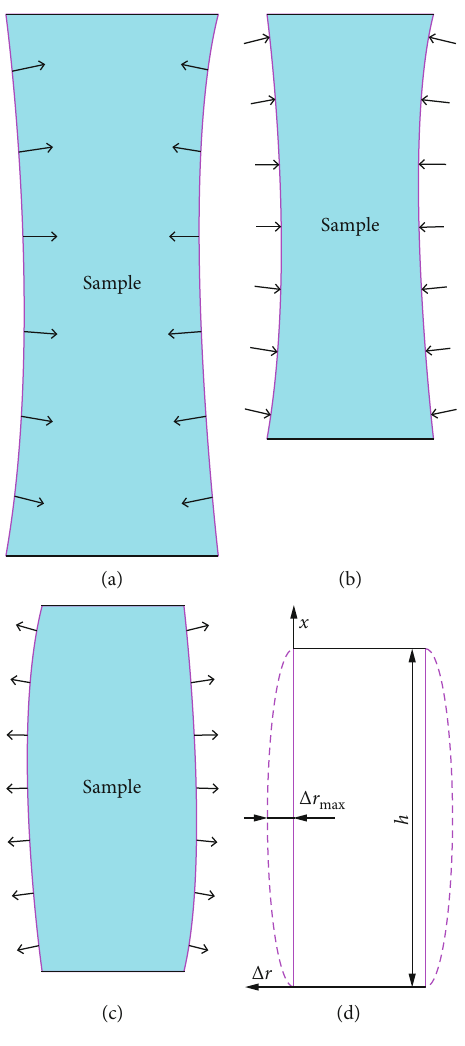
Figure 7: Radial deformation of the sample caused by (a) water cooling, (b) water compression, and (c) the thermal volume change of the con fi ning medium and (d) the deformation